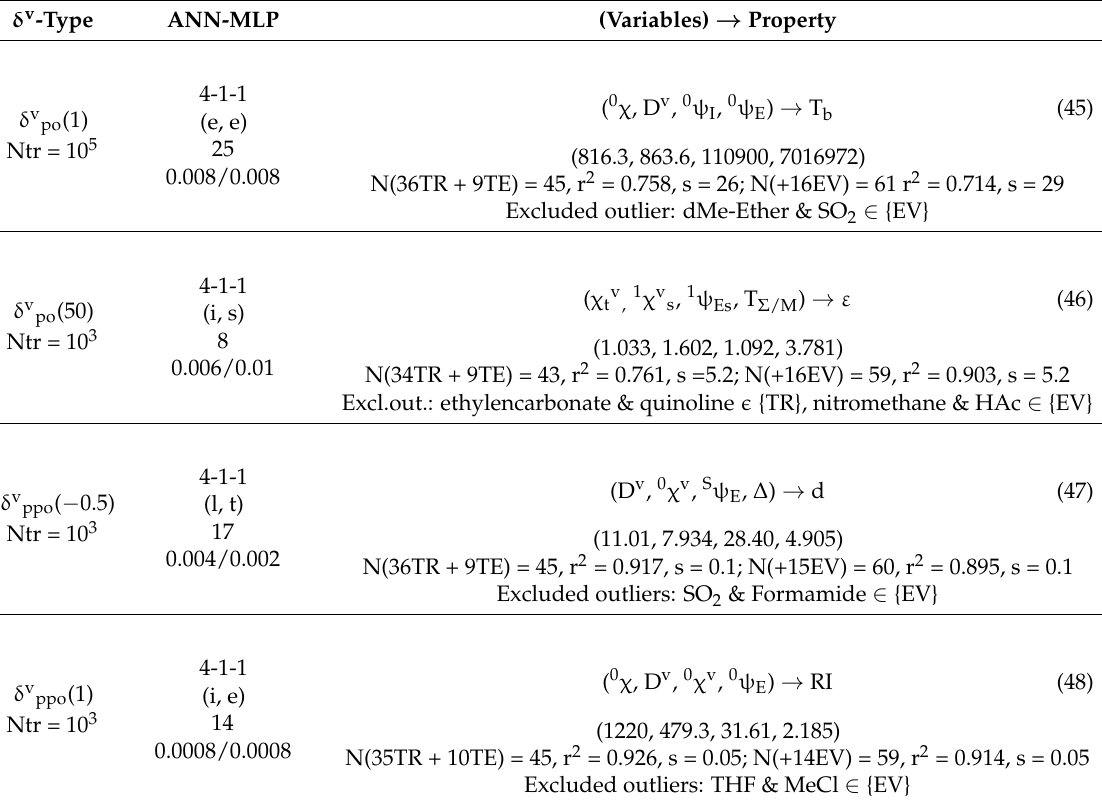
Table 8. ANN-MLP results for the set of descriptors of Table 4 with only one hidden neuron where either one or two indices were deleted, usually, those with the lowest sensitivity values shown in Table 5. The structure is similar to that in Table 5. Only the satisfactory results are here